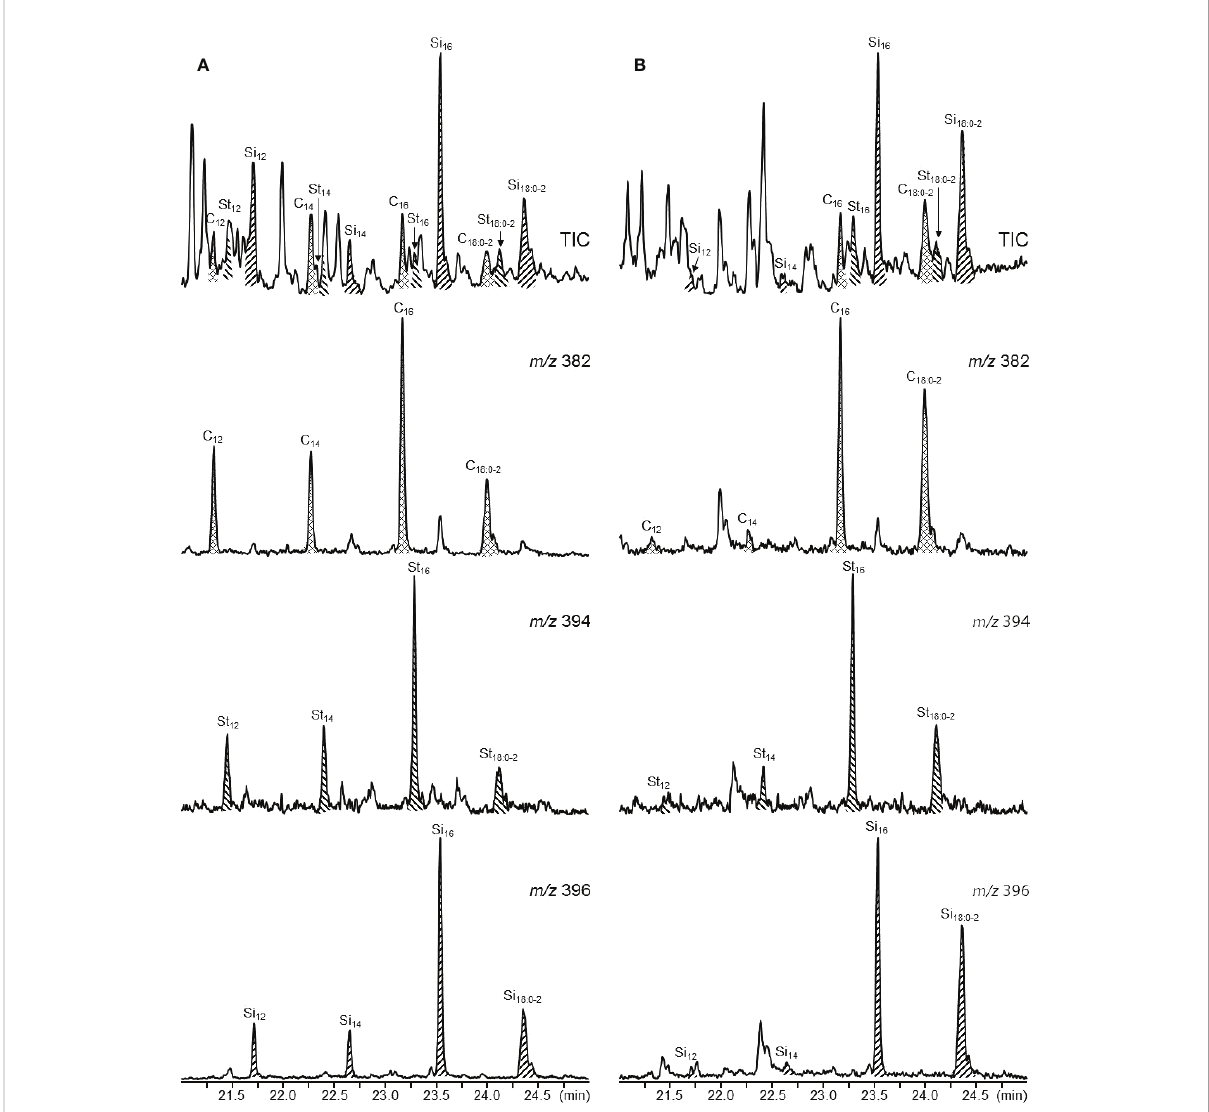
FIGURE 9 Total Ion Chromatograms (TIC) and single ion chromatograms showing the distribution of the different sterol ester series in (A) the rind, and (B) the pith of papyrus stems ( m/z 382, campesterol esters; m/z 394, stigmasterol esters; m/z 396, sitosterol esters). C, campesterol esters; St, stigmasterol esters; Si, sitosterol